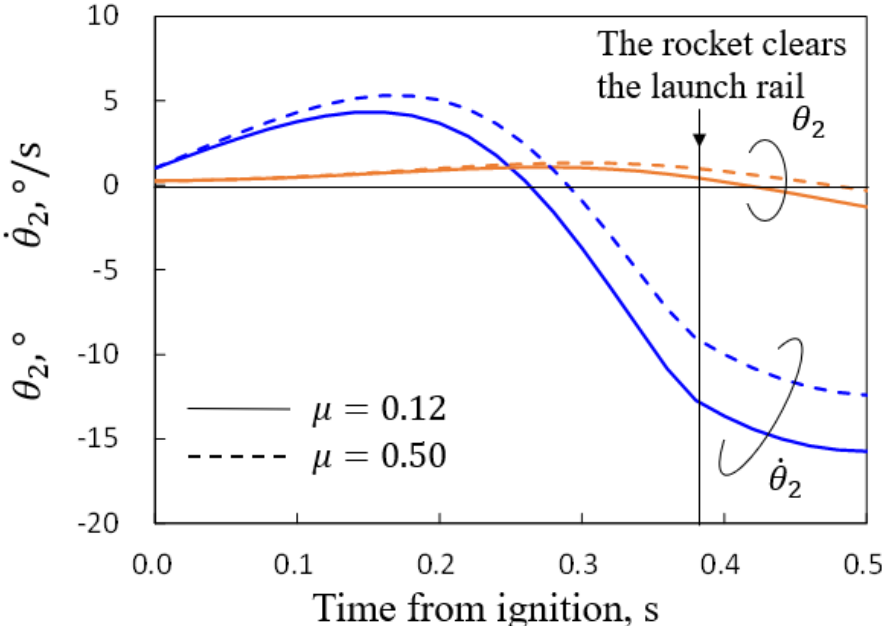
Figure 12. Elevation variations due to the friction coefficient without